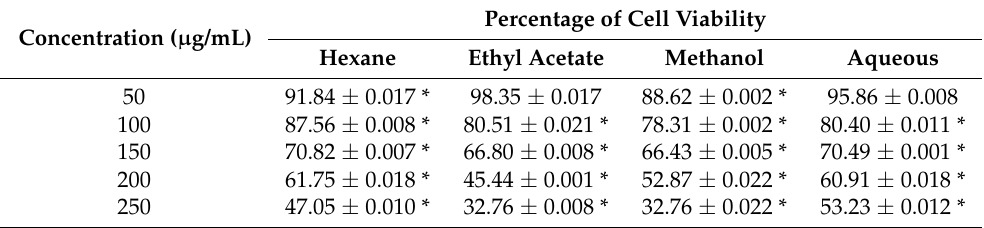
Table 1. Growth inhibitory activity of different solvent extracts of T. terrestris against (L929) cell